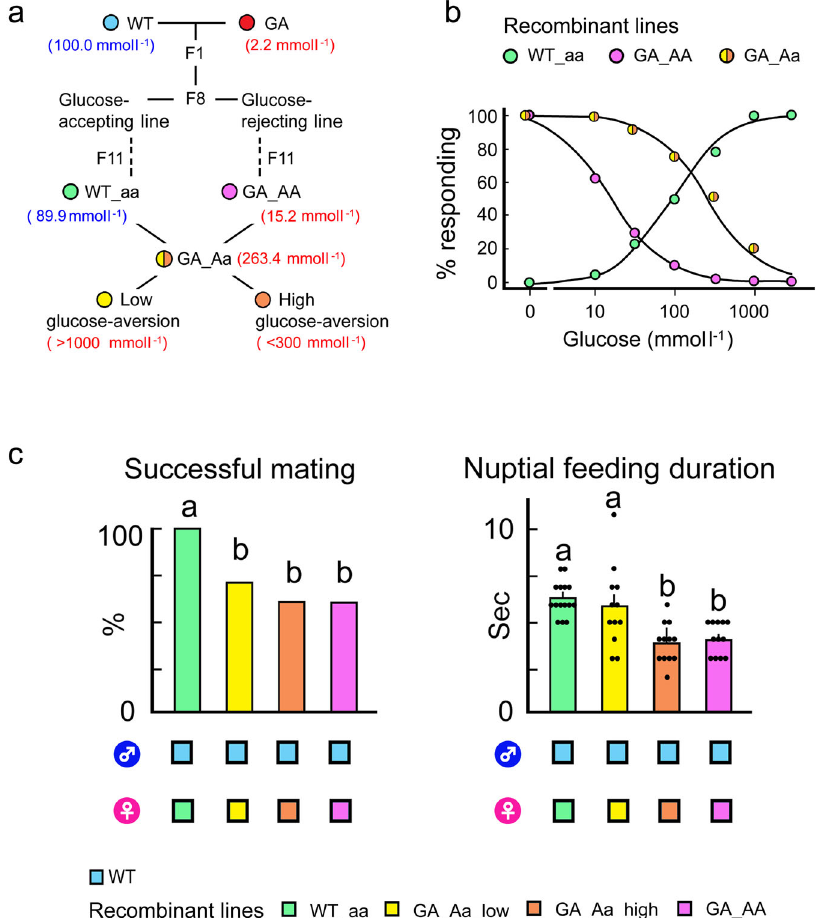
Fig. 3 Recombinant cockroach lines con fi rm the association of interrupted nuptial feeding in females with the glucose-aversion trait. a The experimental design used to generate four recombinant lines. The EC 50 values for glucose acceptance in WT and WT_aa cockroaches (Blue), and glucose rejection in GA, GA_Aa and GA_AA cockroaches (Red) are shown in parentheses ( n > 16 each). b Dose-feeding response curves for glucose in females of three recombinant lines. Because of Mendelian-like segregation of the GA trait, all GA_Aa cockroaches (heterozygous for the GA trait) were glucose- averse, but their sensitivity to glucose was lower than in GA_AA cockroaches. WT_aa cockroaches accepted glucose in a dose-dependent manner. c In no- choi c e mating assays using WT males paired with females from the four types of recombinant lines, GA females with high sensitivity to glucose (GA_Aa_high and GA_aa) had signi fi cantly lower mating success (left, n > 15 each, χ 2 (3) = 8.45, P = 0.018) and shorter nuptial feeding duration (right, ANOVA, Tukey ’ s HSD test, F (2, 14) = 17.65, P = 0.0001), indicating that short nuptial feeding associates with the GA trait. Different letters indicate signi fi cant differences among